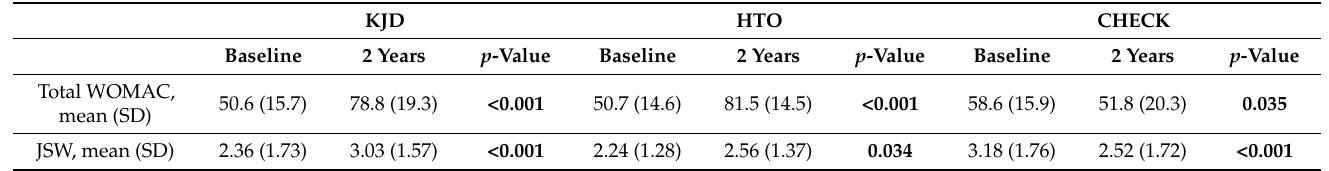
Table 2. Baseline and two-year WOMAC and JSW for the KJD, HTO and CHECK patient